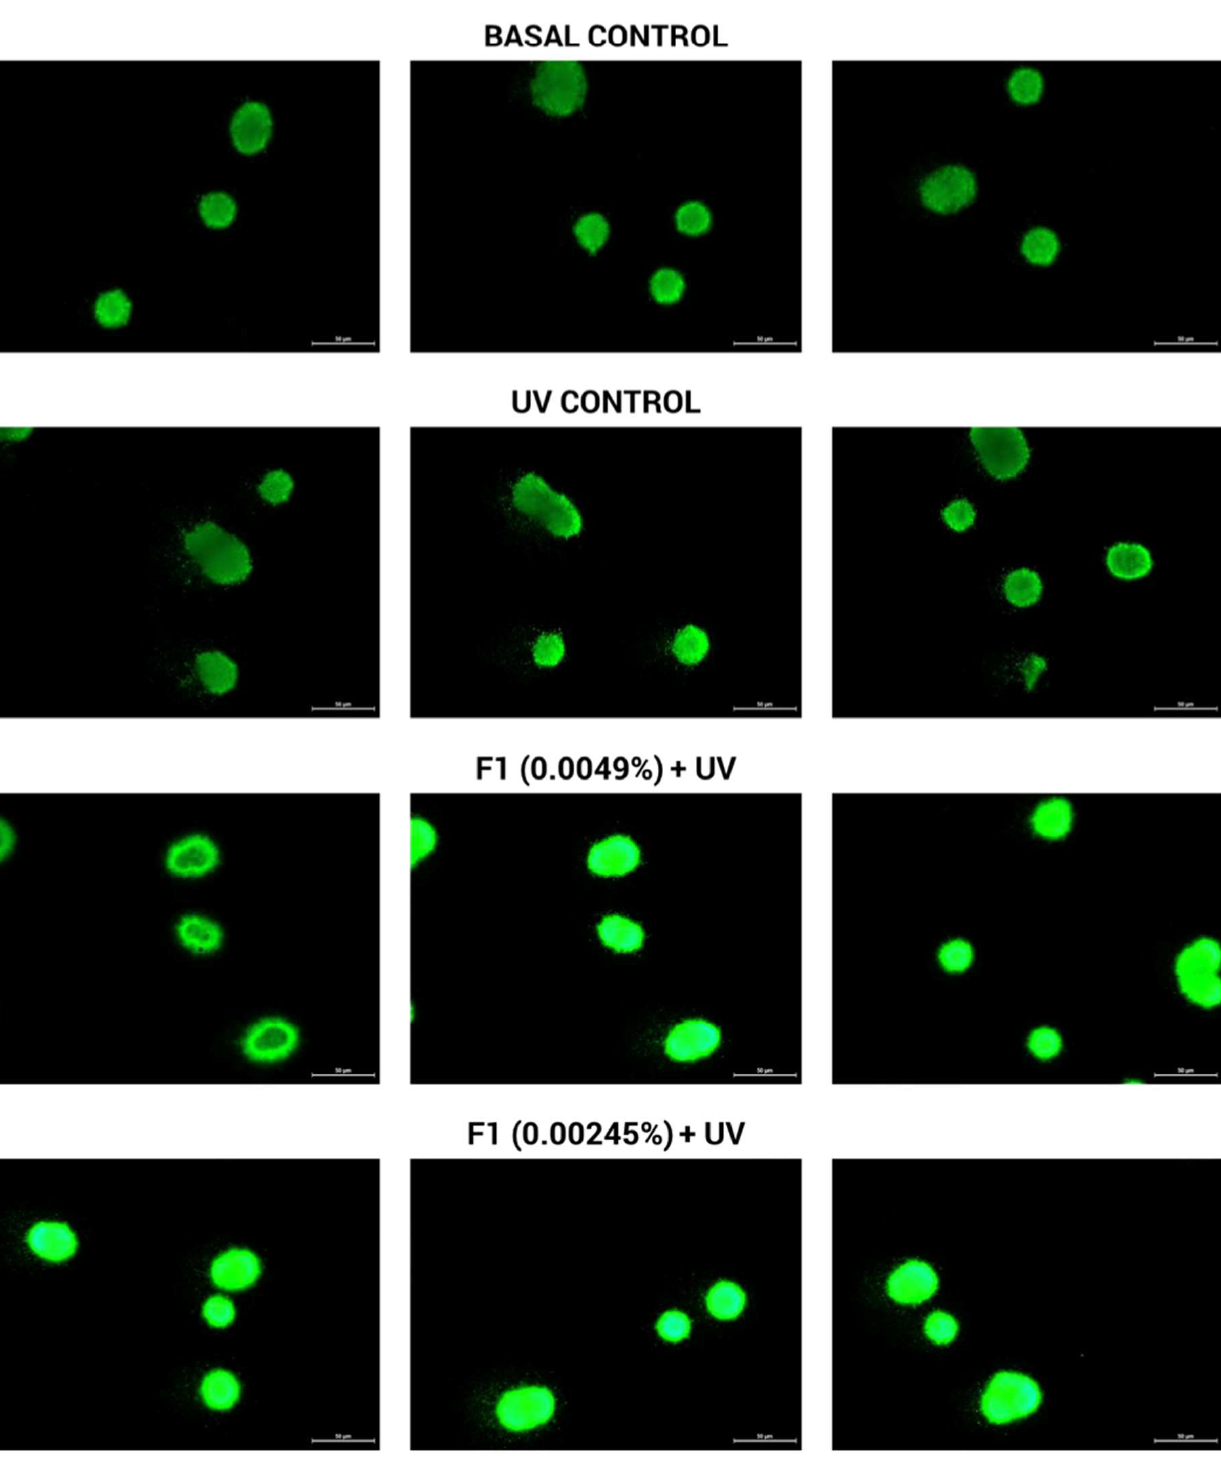
Figure 3. Evaluation of DNA protection potential of samples F1, F2, F3 and F4 in human keratino- cytes after exposure to UV radiation. Data represent the mean ± standard deviation of three inde- pendent experiments. * p < 0.01 compared to the UV control group; ## p < 0.01 compared to the basal